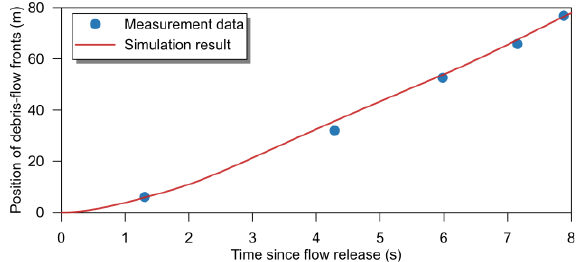
Figure 3. Flow front position at different times.